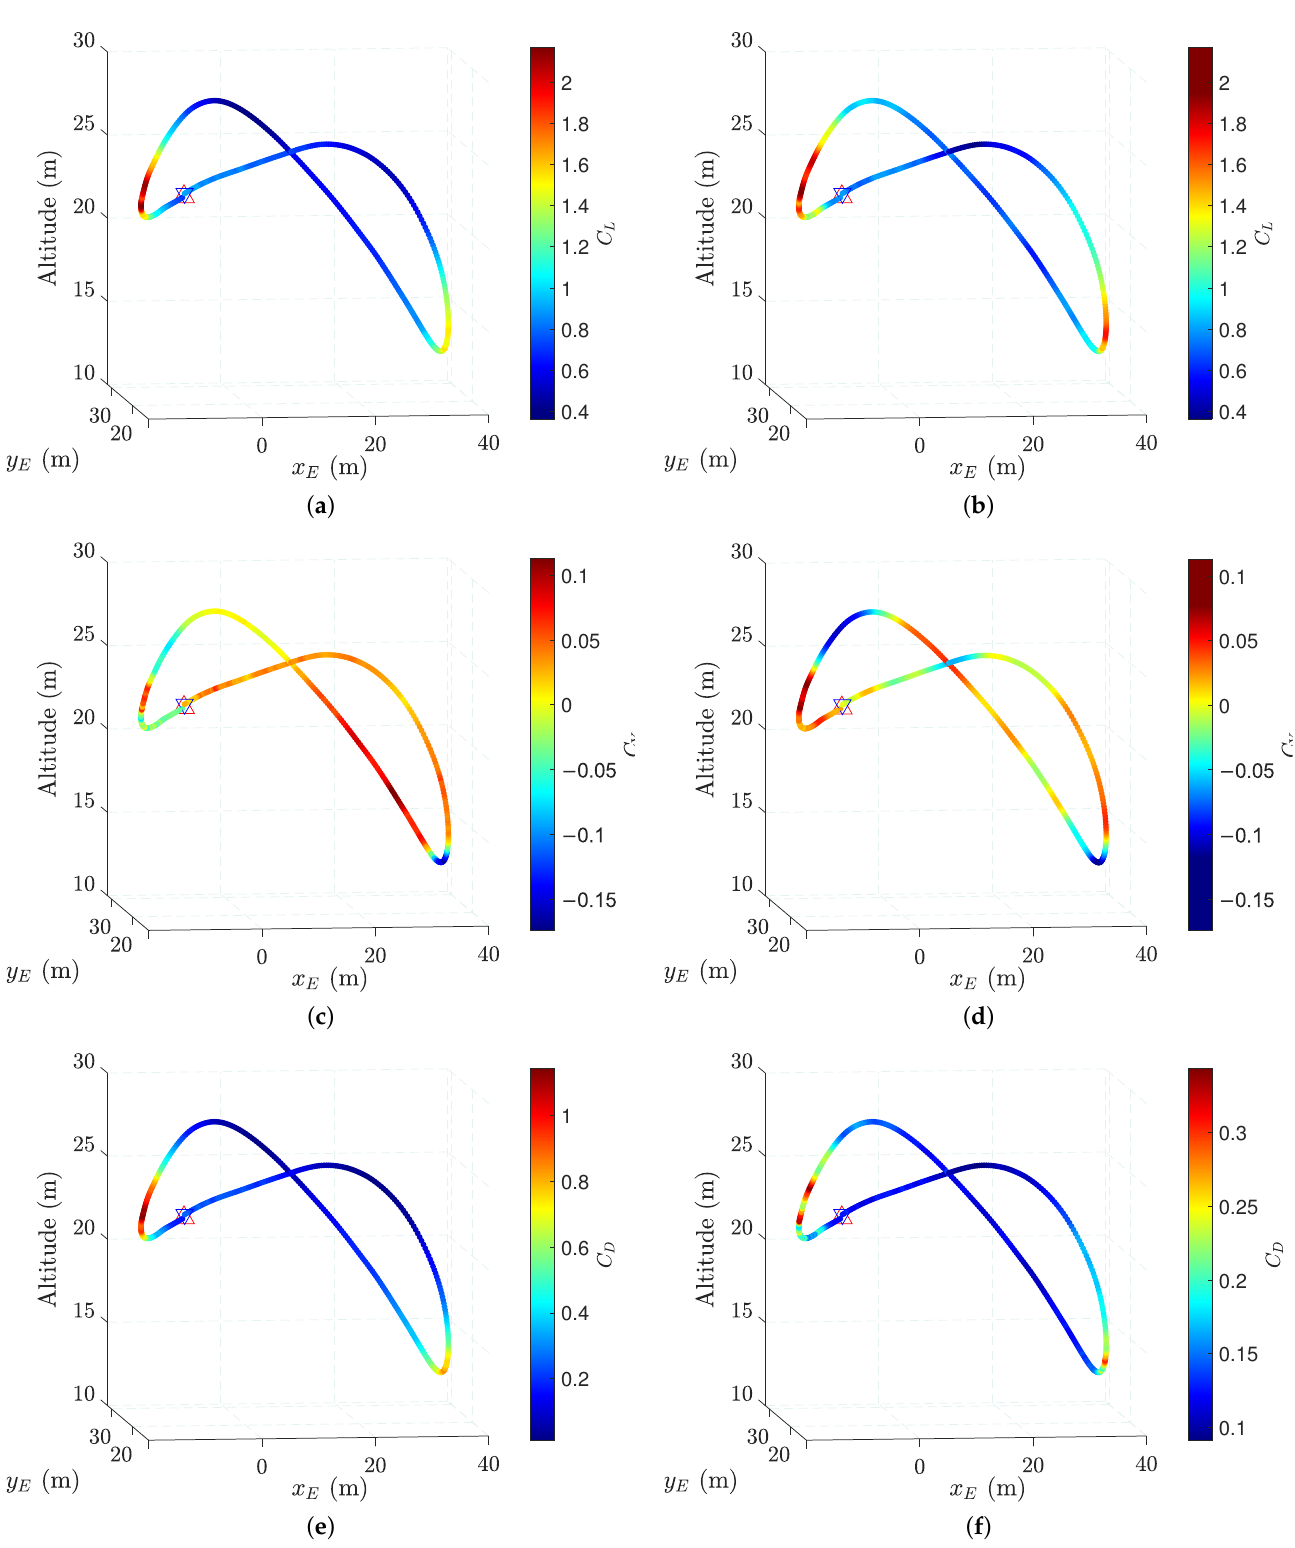
Figure 7. Kite trajectory with color map representing the force coefficients coming from experimental data ( left figures ) and UnPaM simulations ( right figures